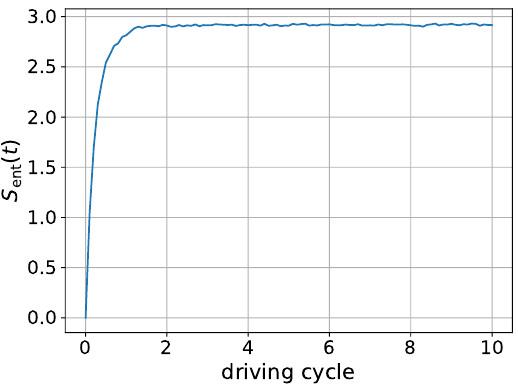
Figure 7: Entanglement entropy of one species as a function of time. This data was taken on a chain of length L = 6, which agrees with the Page value [ 99 ] S